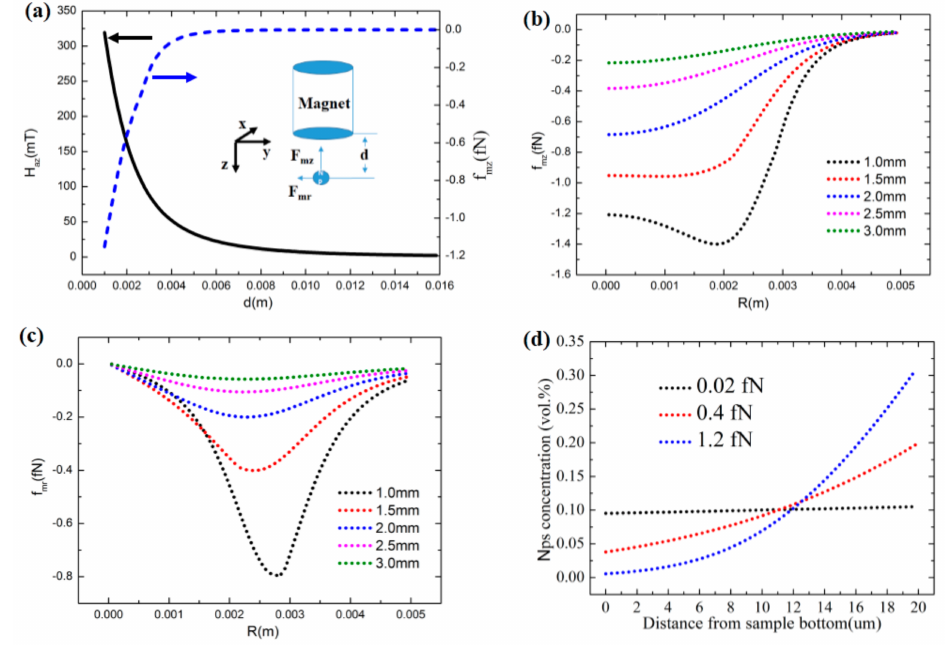
Figure 1. ( a ) Magnetic field and force distribution in the z direction of magnet; ( b , c ) magnetic force in the axial and radial directions in different locations; ( d ) concentration distribution after 1.2 × 10 3 s with different applied